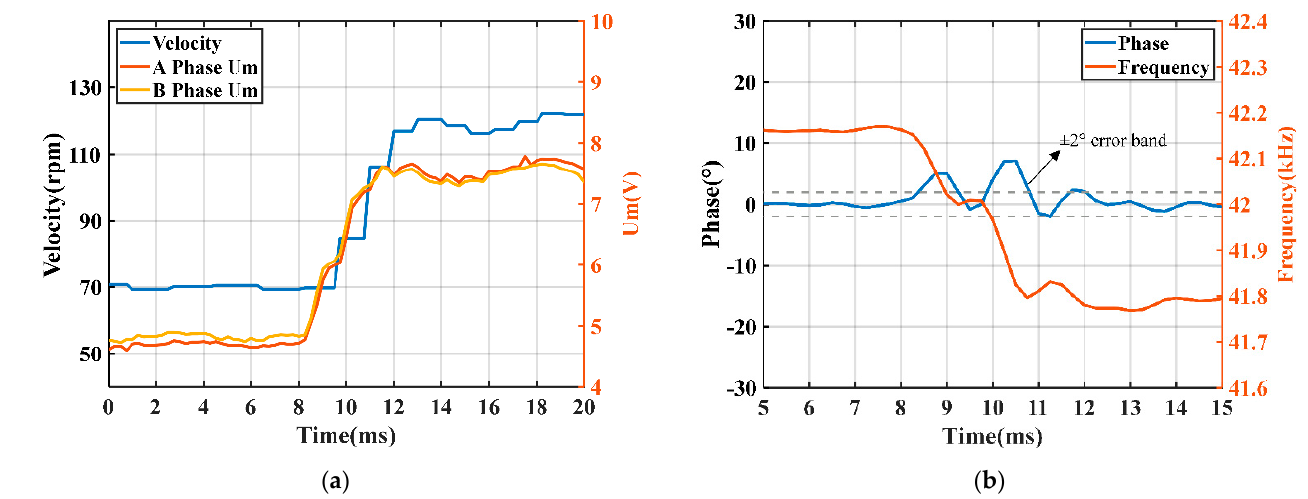
Figure 10. Verification of the proposed scheme: ( a ) velocity and vibration stabilization process; ( b ) frequency tracking process.